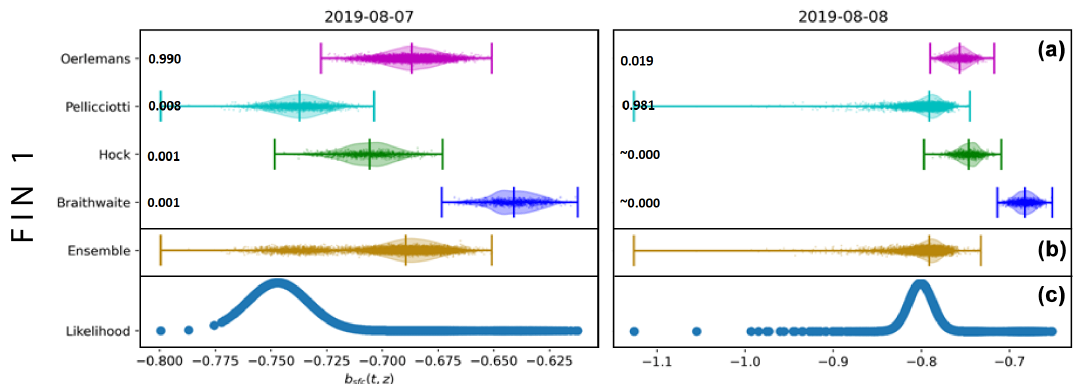
Figure 12. Violin plots with scattered particles as an example for a fast switch in assigned model probability (cf. Fig. 11). The example refers to Findelgletscher (station FIN 1). Shown are (a) predictions of the individual models, (b) the ensemble prediction, and (c) the particle likelihood for 2 subsequent days. The individual model probabilities are given to the right of the model names. Note that the ensemble is dominated by the OerlemansModel for the first day (left) and by the PellicciottiModel for the second day (right).